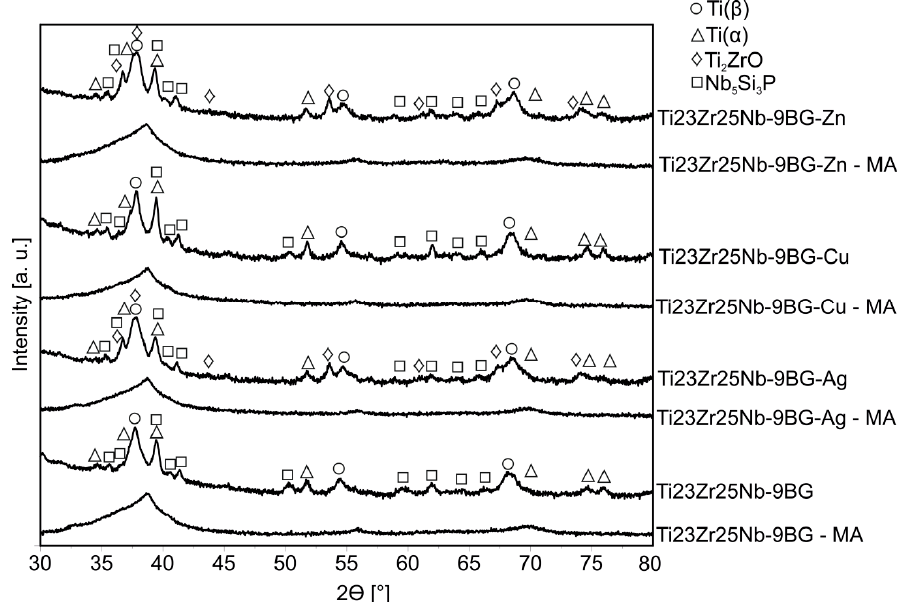
Figure 6. XRD spectra of Ti23Zr25Nb-based composites with the 9 wt.% 45S5 Bioglass and 1 wt.% Ag, Cu, Zn content sintered at 800 °C for 0.5 h in an argon atmosphere in contrast with mechanically alloyed powders for milled for 16 h and the based Ti23Zr25Nb-9BG composite sintered with the same parameters and mechanically alloyed for 16 h.